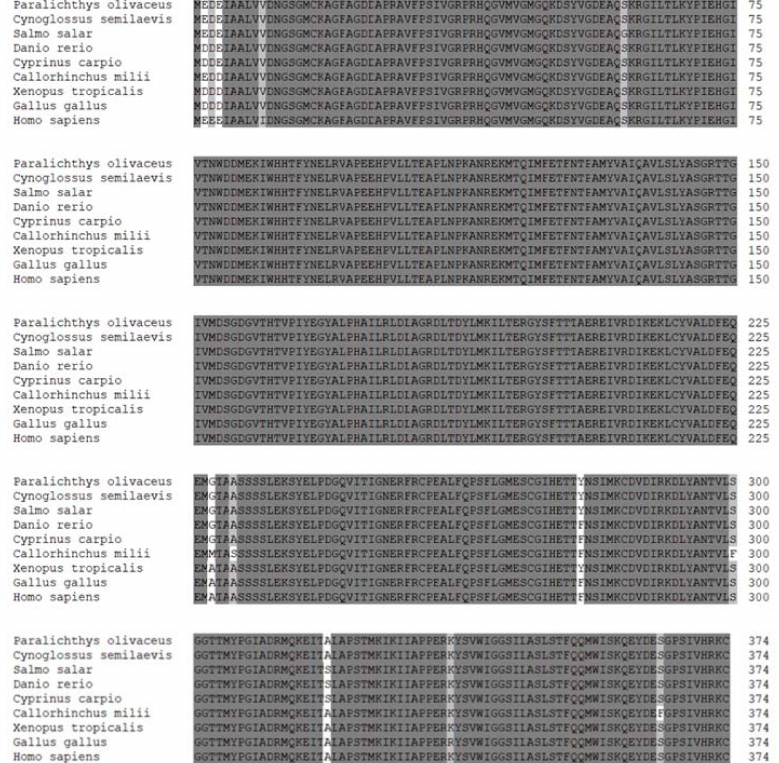
Figure 2. Multiple alignments of full-length β -actin amino acid sequences with eight other species. If 100% conservation exists in the seven sequences, then the amino acid shading is in